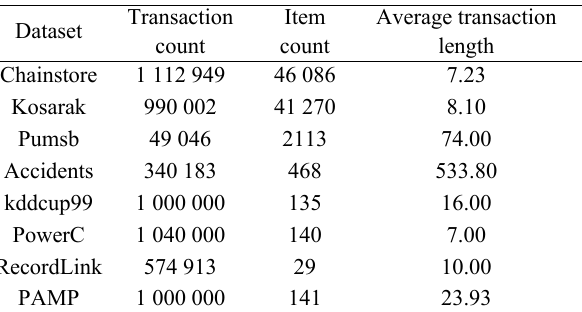
Table 5 Characteristic of the datasets. Algorithm 2 Reduce